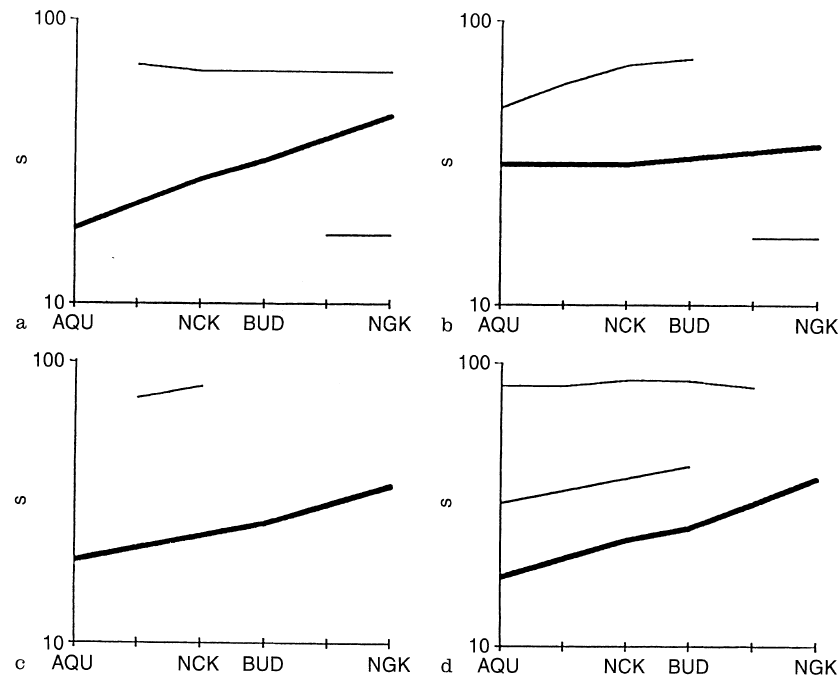
Fig. 12a–d. Location of the amplitude max- ima on 22 May 1991, a 0843–0846 UT, b 0847–0849.5 UT, c 0853–0855.5 UT and d 0855.5–0857 UT. The lines indicate the position of amplitude maxima, the thicker the line, the stronger the amplitude maxima. Short periods (about 15 s) are only present at NGK, thus in a and b the corresponding lines are not necessarily horizontal